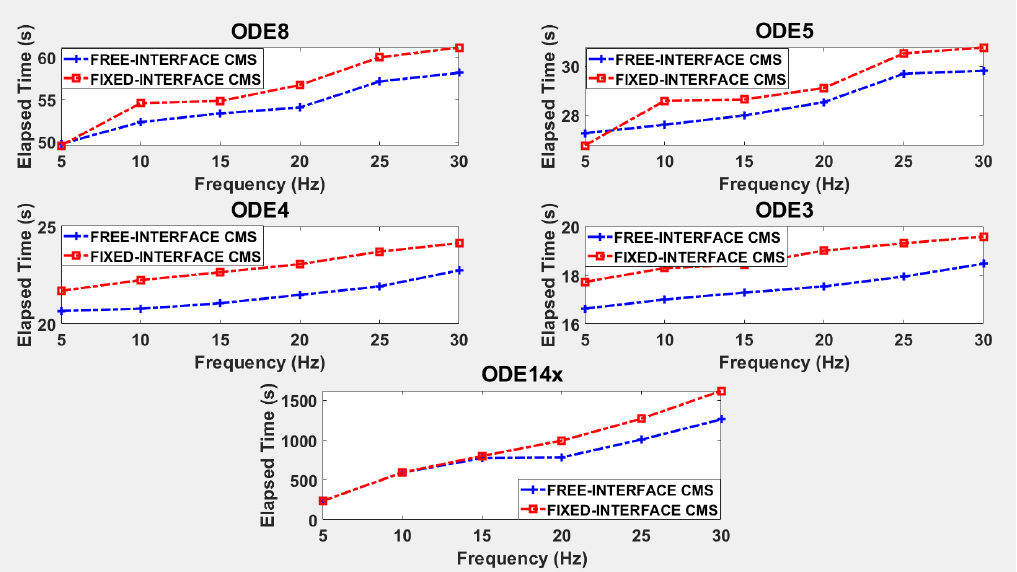
Figure 10. Elapsed time for various frequency ranges of digital